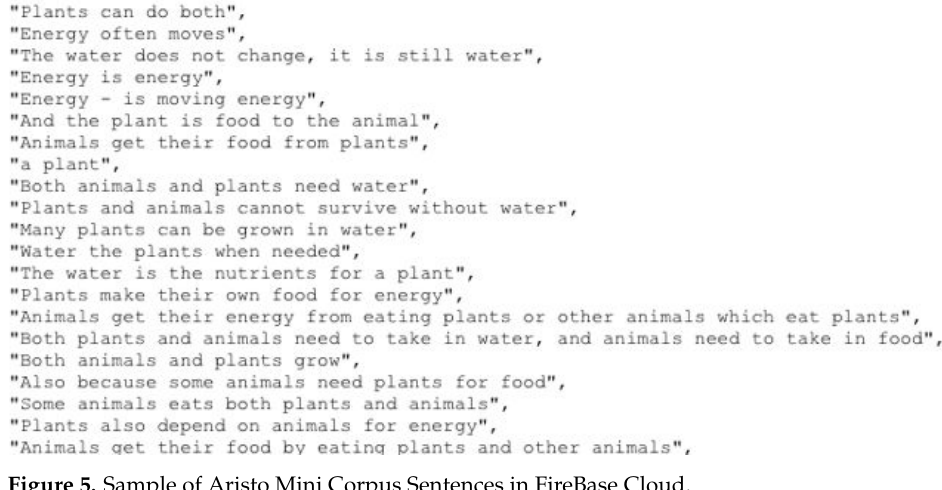
Figure 5. Sample of Aristo Mini Corpus Sentences in FireBase